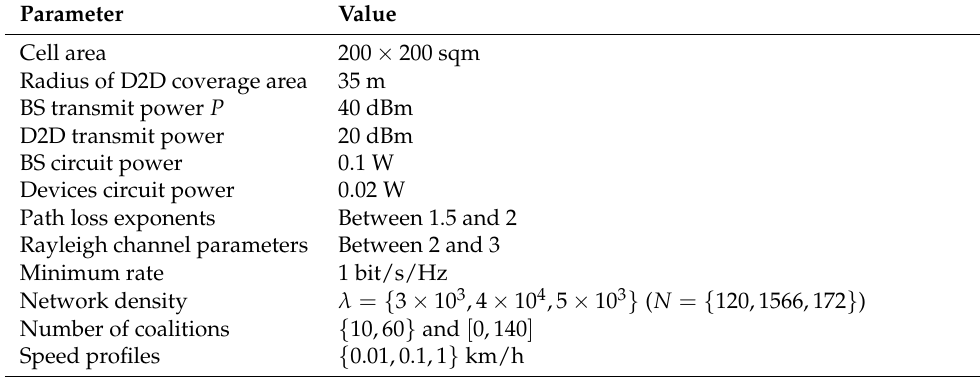
Table 2. Simulation